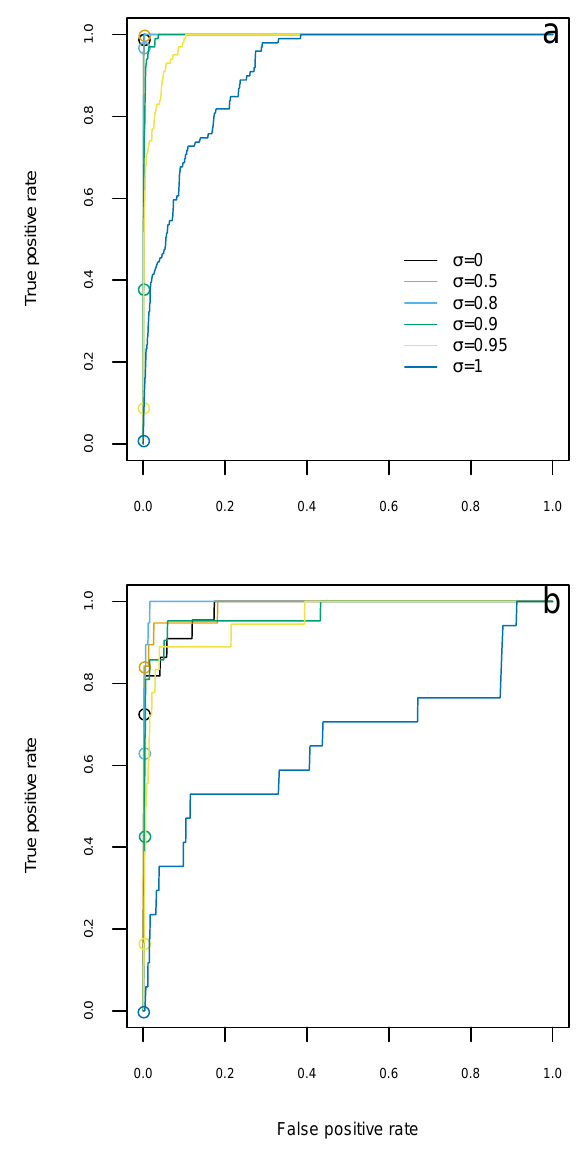
Figure 2 – Power and false positive rate of the genome scan for increasing decision thresholds. Receiver operating characteristic curve is estimated from 100 replicates of simulated data of one population of N = 500 diploid individuals, sampled twice with τ = 25 generations between samples, selection coefficient s = 0.5 and selfing rate σ . (a) Selection on new mutation. (b) Selection on standing variation. Circles mark the values for positive threshold of p -value>0.001, which is the threshold used in Fig.